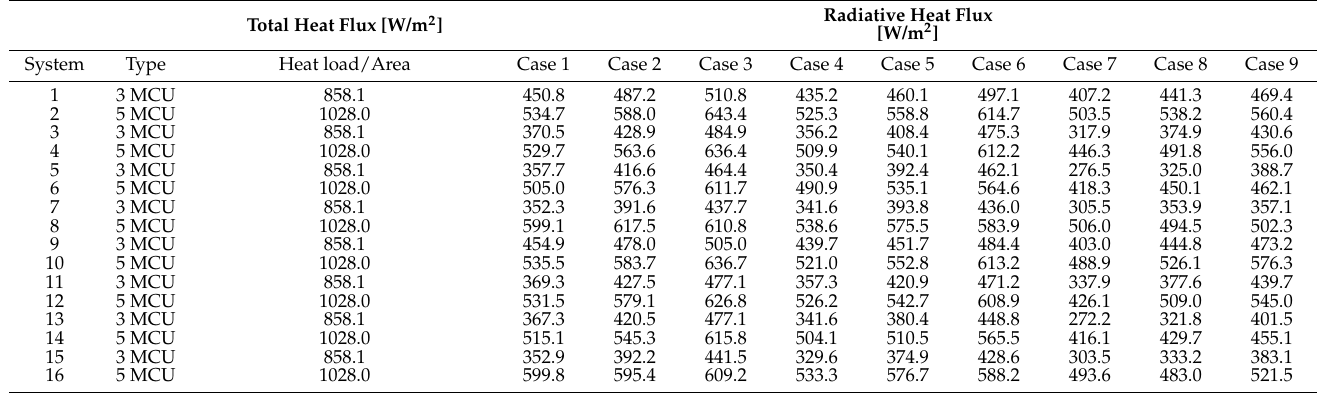
Figure A2. System temperature contour for all studied cases of Configuration 2. Table A1. System radiative heat fluxes for all studied cases of Configuration 2